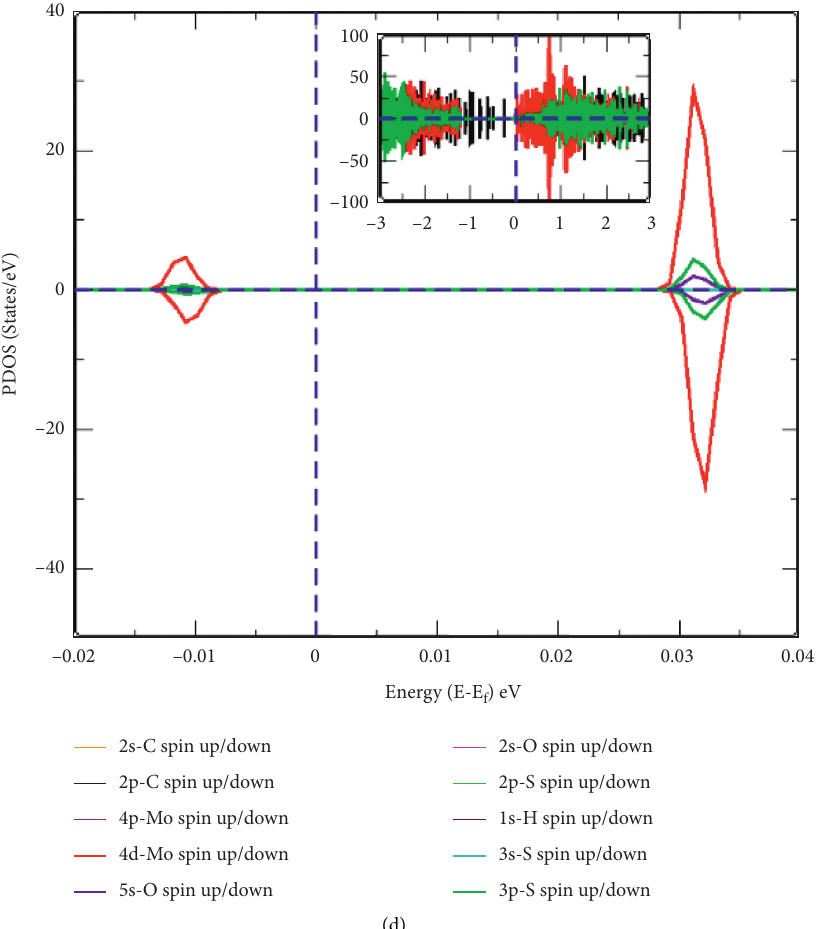
Figure 3: (a) Band structure of system-I, (b) DOS of up-spin and down-spin states of electrons in the orbitals of C Mo, S O, and H atoms of system-I, (c) PDOS of total up-spin and total down-spin states of electrons in the orbitals of C Mo, S O, and H atoms of system-I, (d) PDOS of individual up-spin and down-spin states of electrons in the orbitals of C Mo, S O, and H atoms of system-I. In all DOS and PDOS, the horizontal dot line separates spin states and the vertical dot line separates the electronic bands, and also in band plot, the horizontal dot line represents the Fermi energy level; insets in DOS and PDOS represent the spin states within a large energy range along x